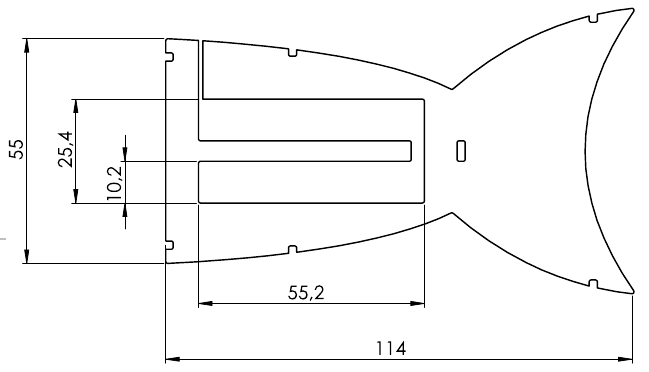
Figure 1. Dimensions of the fish fin structure as the core part of the robot’s body in mm. Rectangle parts represent void spaces down to the neutral plane, providing cavities for the hydrogel.